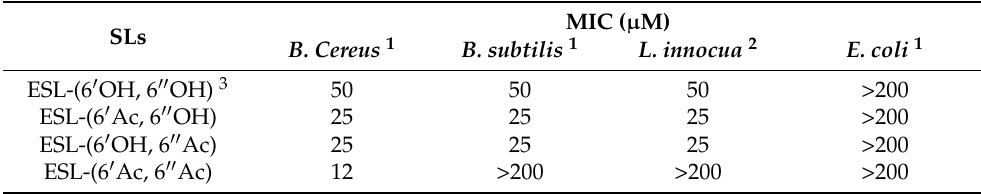
Table 2. Effect of degree of acetylation on minimum inhibitory